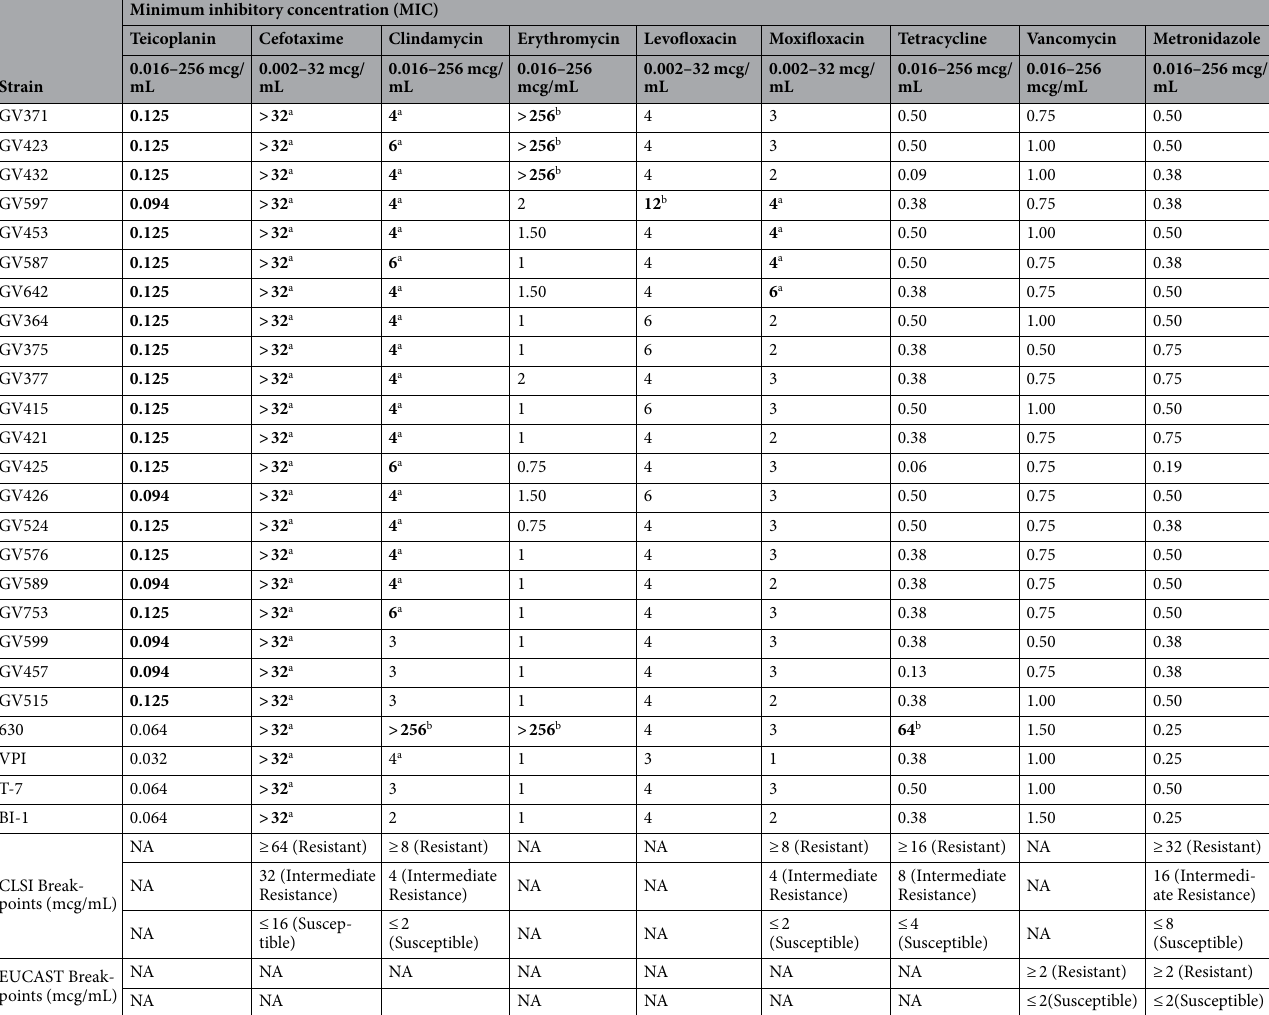
Table 1. Antibiotic susceptibility profiles of RT106 clinical isolates (this study). Numbers in bold font represent high MIC values. a Denotes that strain is moderately resistant to specific antibiotics. b Denotes that strain is highly resistant to specific